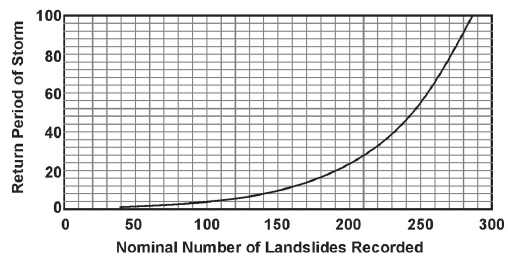
Figure 9. The relationship between landslide occurrence and landslide-generating rainfall at